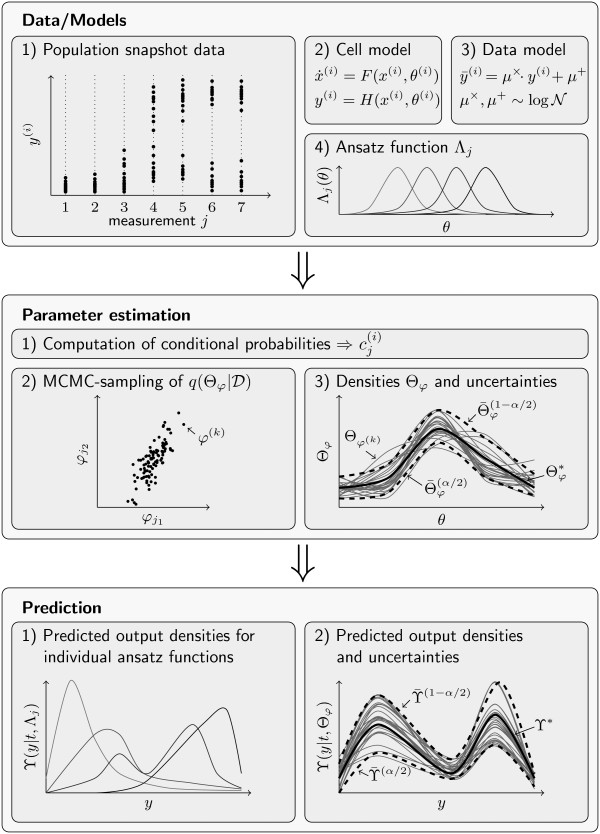
Illustration of the analysis procedure. The main steps as well as their order is shown.